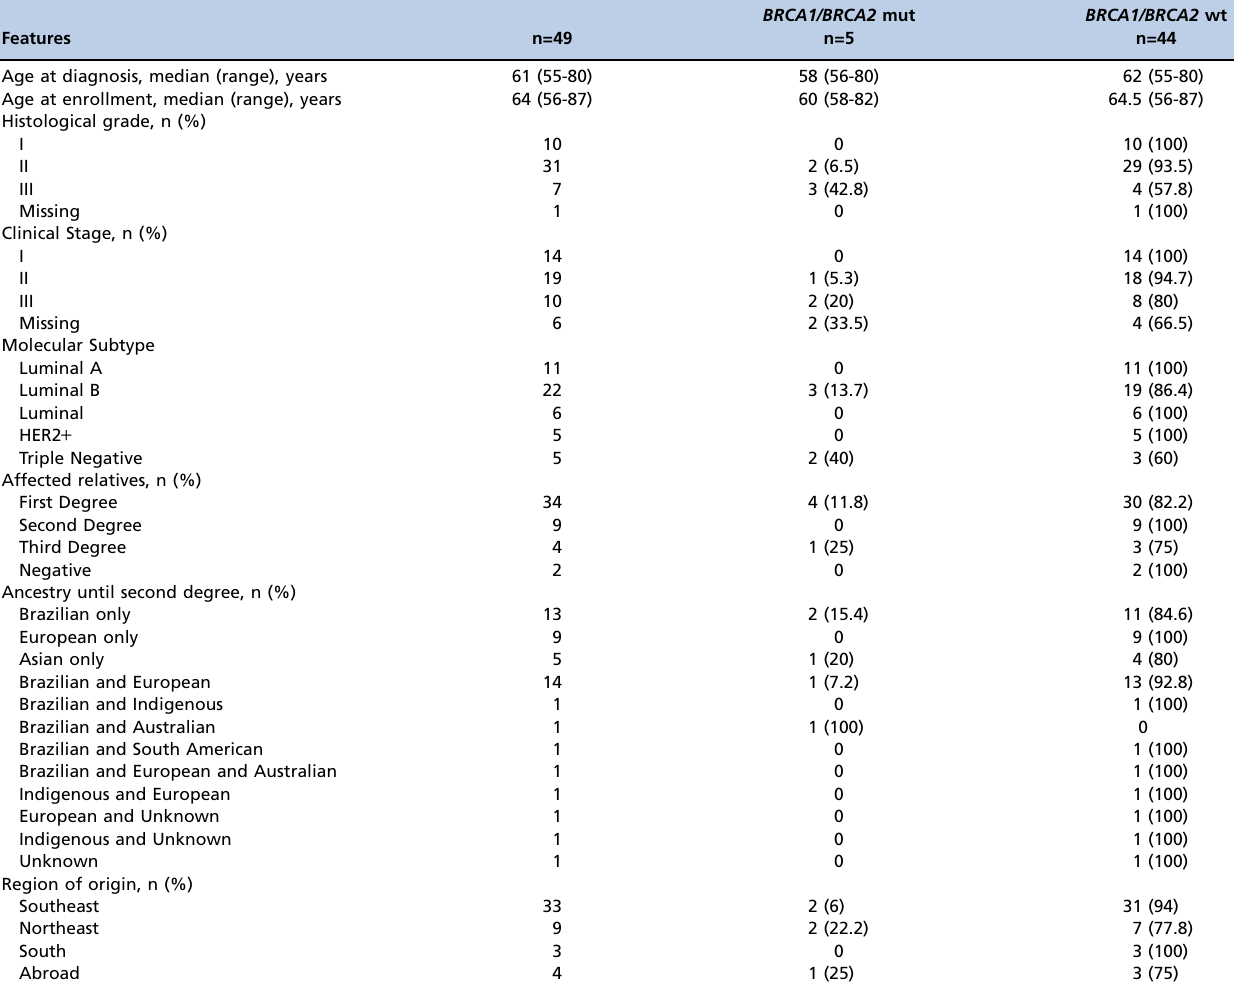
Table 1 - Clinical and pathological features of breast cancer patients according to deleterious BRCA1 and BRCA2 mutations.